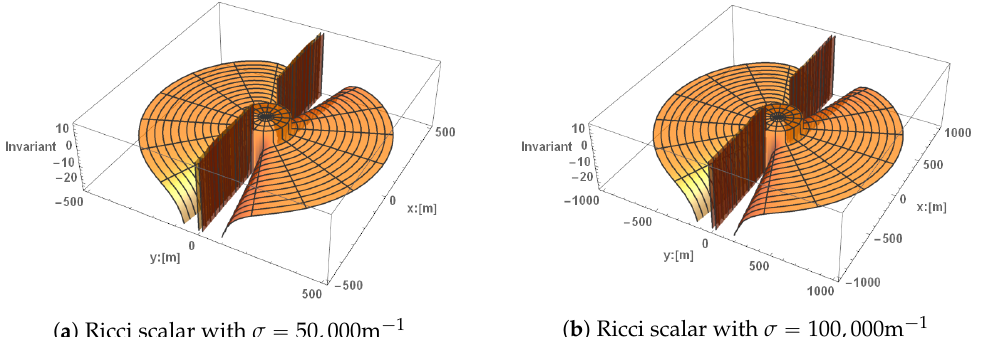
Figure 3. The warp bubble skin depth, σ , of the Ricci Scalar R is plotted in the figures above. The other parameters were set to be ρ “ 100 m, a “ 1.0 m s ´ 2 , and t “ 1 s. The plots were rendered using Mathematica’s ® RevolutionPlot3D. It plots a function by rotating the function around the Z-axis. The amount that the space diverges from being flat is represented by the invariant function’s magnitude, and its amount is labeled on the vertical axis. The X and Y-axis are displayed on the plots, and they display the distance from a spaceship in the flat portion at the center of each figure. Each radial line in the left hand column corresponds to a distance of approximately 33 m. The constant portion to the right of the harbor is to the front of the warp bubble, and the constant portion to the left of the harbor is the back of the warp bubble.